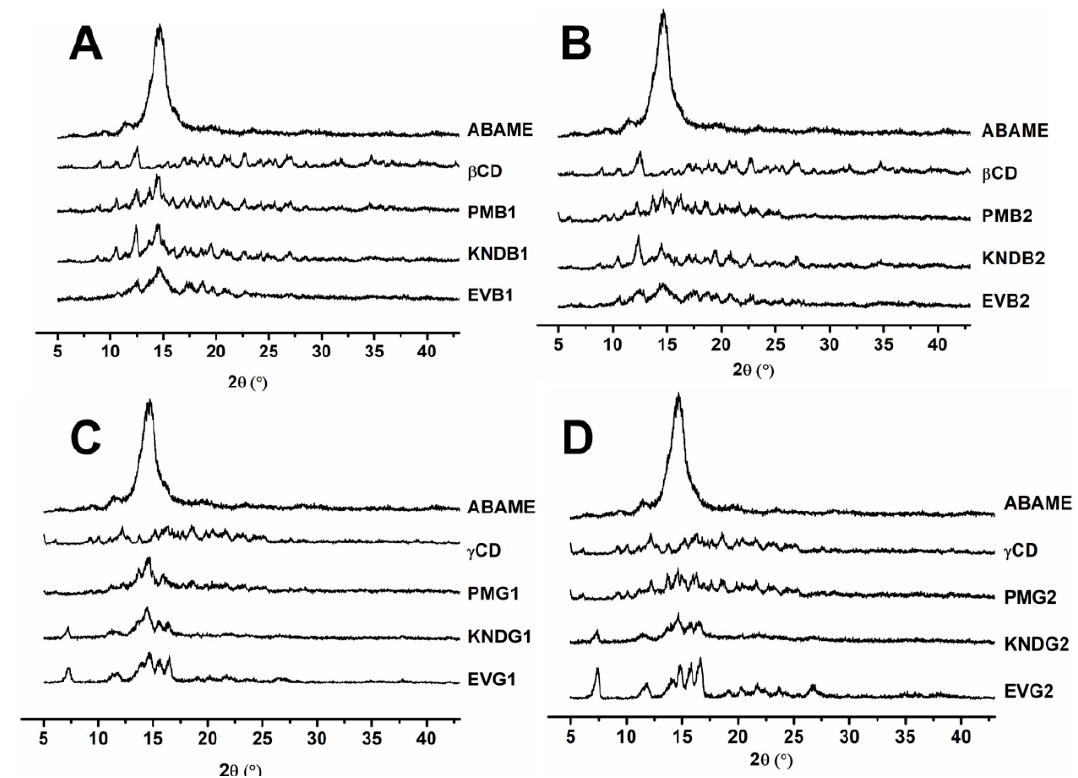
Figure 5. X-ray diffraction profiles of individual compounds, namely α , β -amyrenone (ABAME), β -cyclodextrin ( β CD) and γ - cyclodextrin ( γ CD), as well as inclusion complexes (ICs). ICs prepared with ABAME and β CD at 1:1 ( A ) and 2:1 ( B ) molar ratios using physical mixture (PMB1 and PMB2), kneading (KNDB1 and KNDB2), and rotary evaporation (EVB1 and EVB2), respectively. ICs prepared with ABAME and γ CD at 1:1 ( C ) and 2:1 ( D ) molar ratios using physical mixture (PMG1 and PMG2), kneading (KNDG1 and KNDG2), and rotary evaporation (EVG1 and EVG2), respectively.